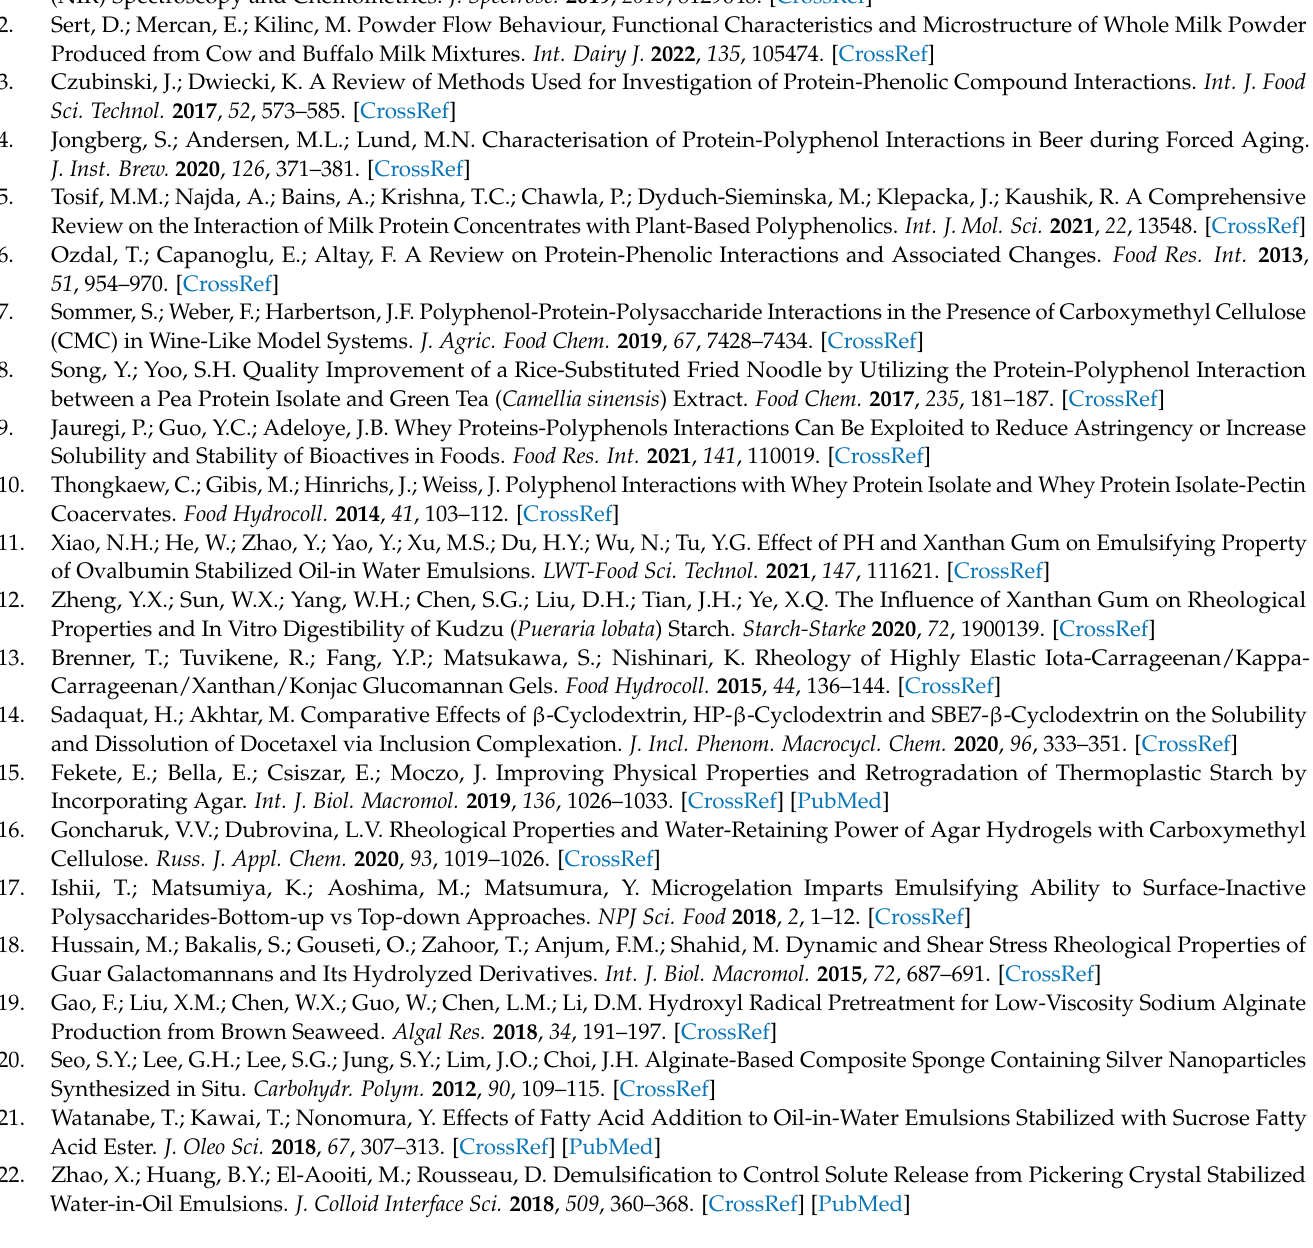
bility test of milk tea; Table S2: Box—Behnken design milk tea stabilizer combination formula and results; Table S3: Variance analysis of response surface test